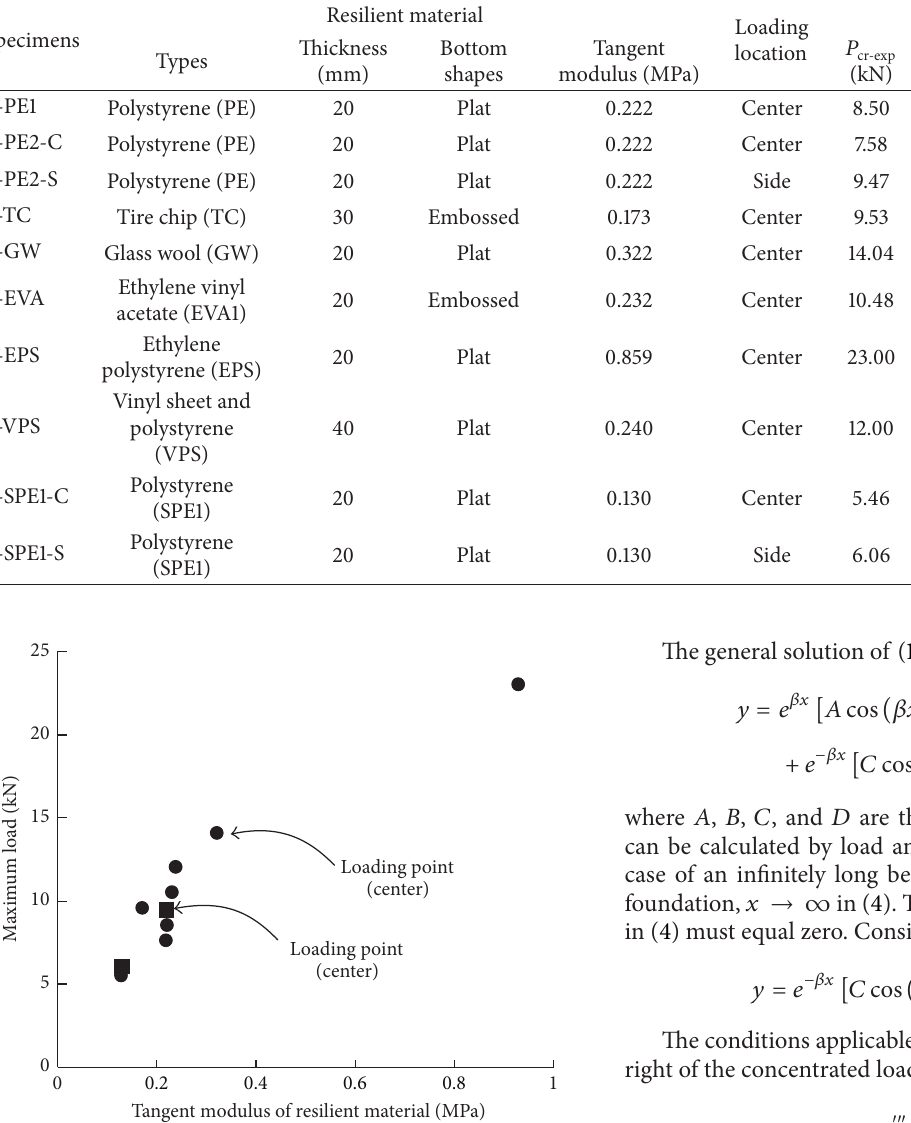
Figure 5: Relationship between maximum load of floating floors and tangent modulus of resilient